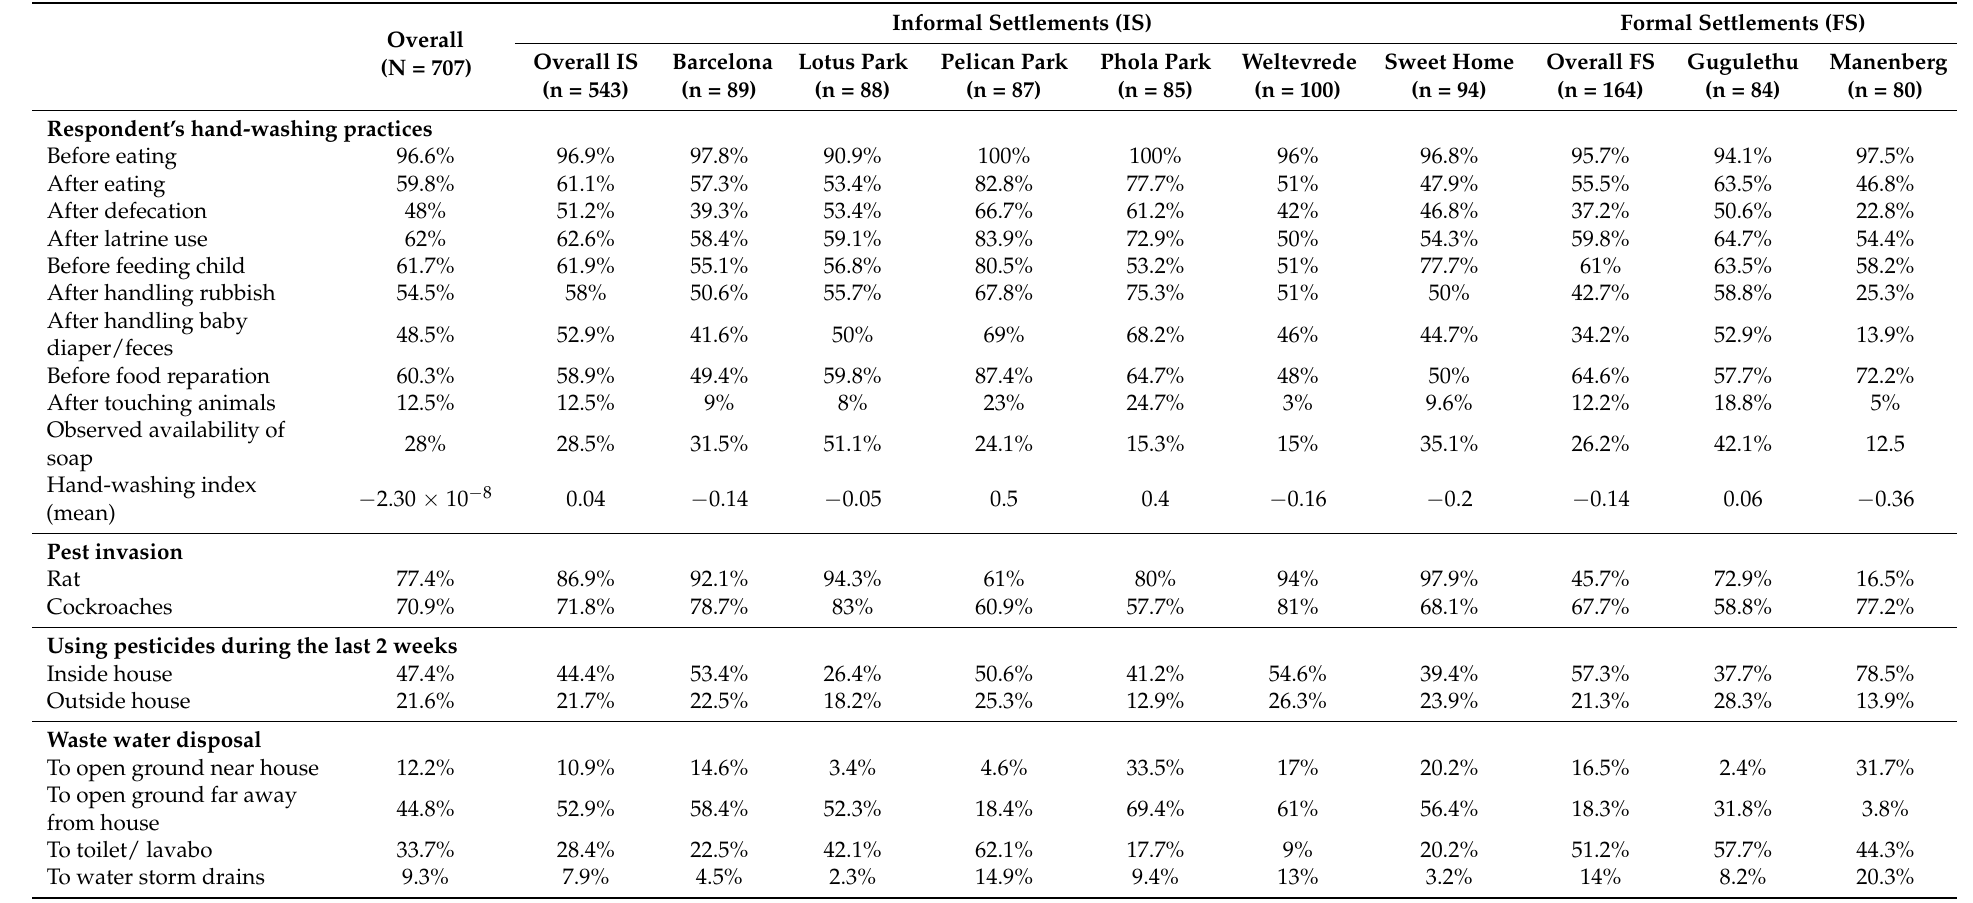
Table 3. The hygiene in participating households from informal and formal